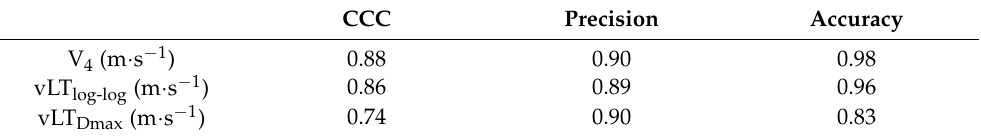
Figure 3. Bland-Altman plot showing the bias and limits of agreement between MLSSv, vLT Dmax , and vLT log-log . CCC of the methods are shown in Table 2, where <0.90 indicates a poor strength of agreement between the methods. Table 2. Concordance correlation coefficient between MLSSv and the three lactate indexes determined in the incremental step test.